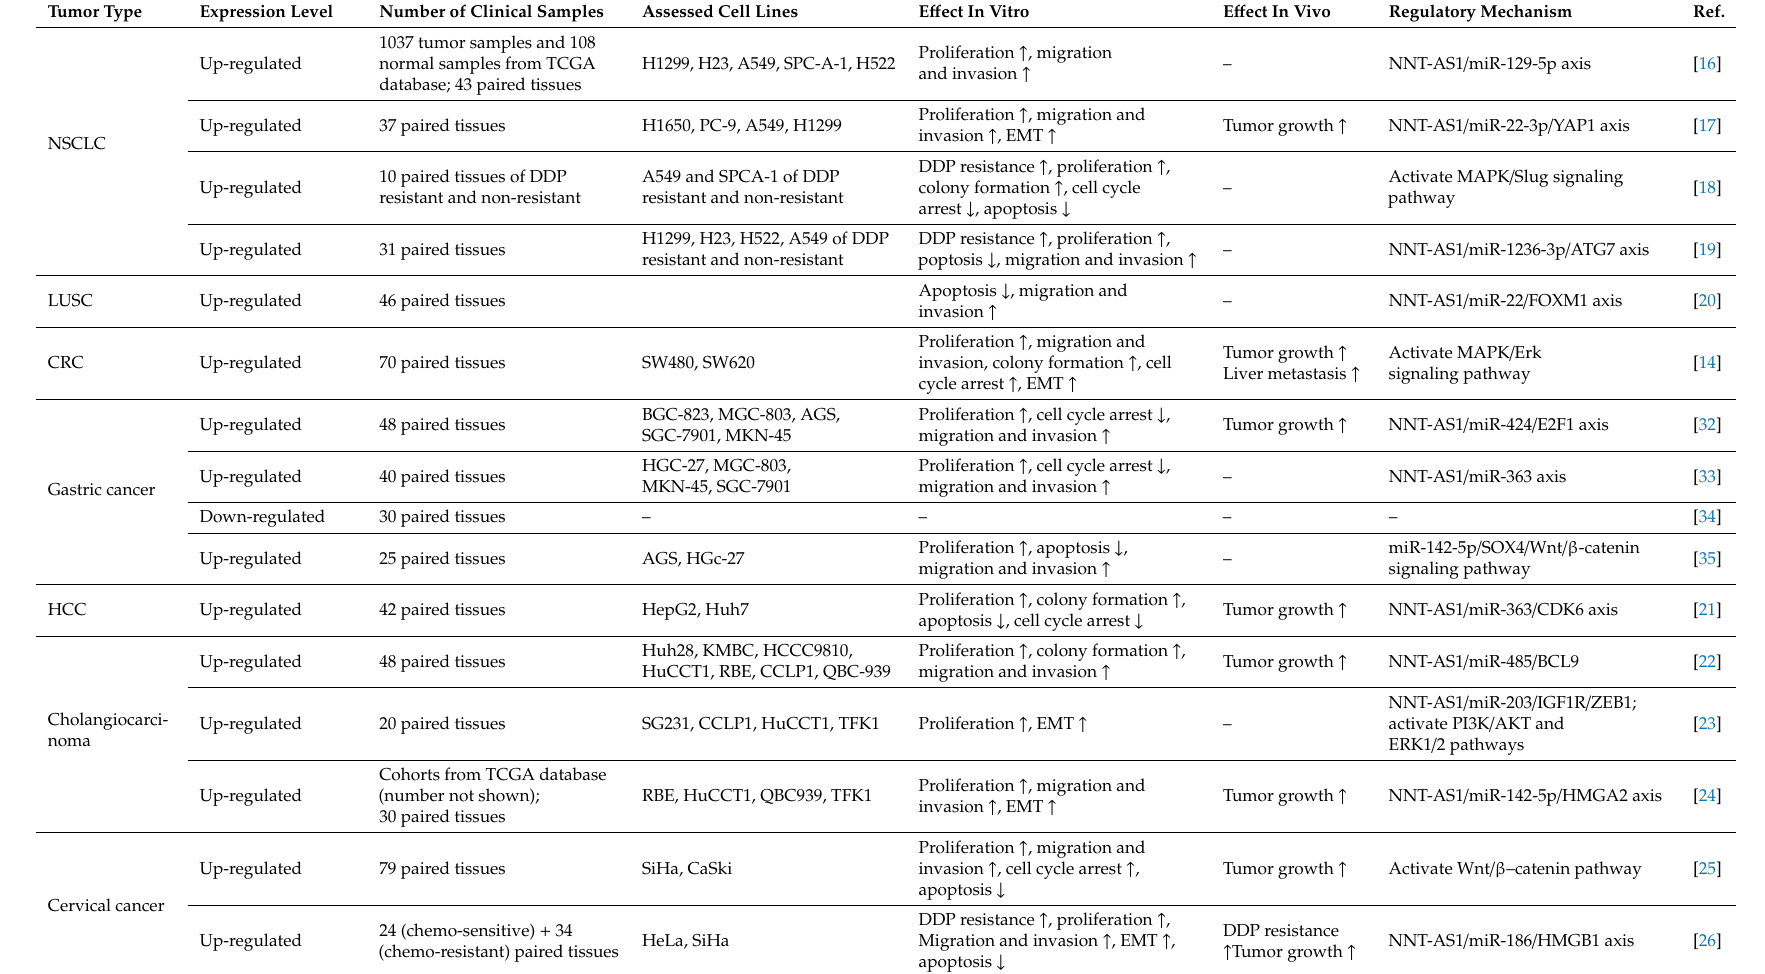
Table 1. The role of NNT-AS1 in di ff erent human